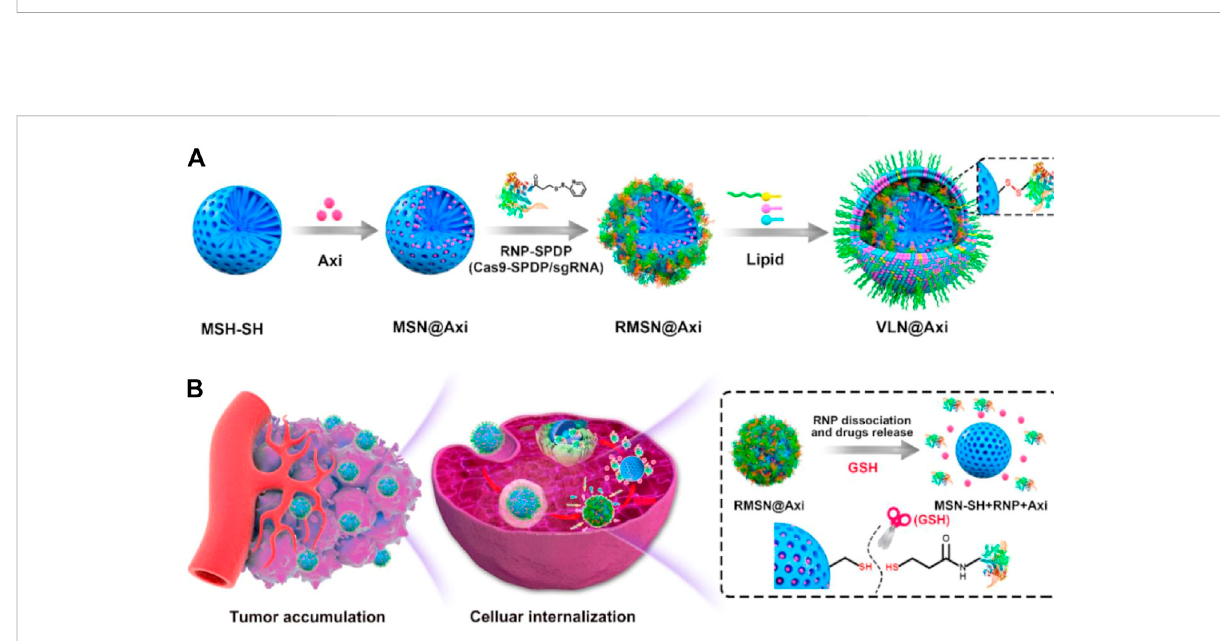
FIGURE 8 Schematic illustration for the synthesis of VLN@Axi (A) and delivery process (B) after intravenous injection. Reproduced with permission from Ref (Liu et al., 2020).